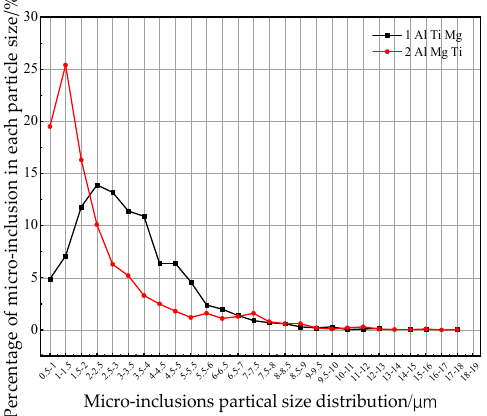
Figure 5. Micro-inclusion particle size distribution.